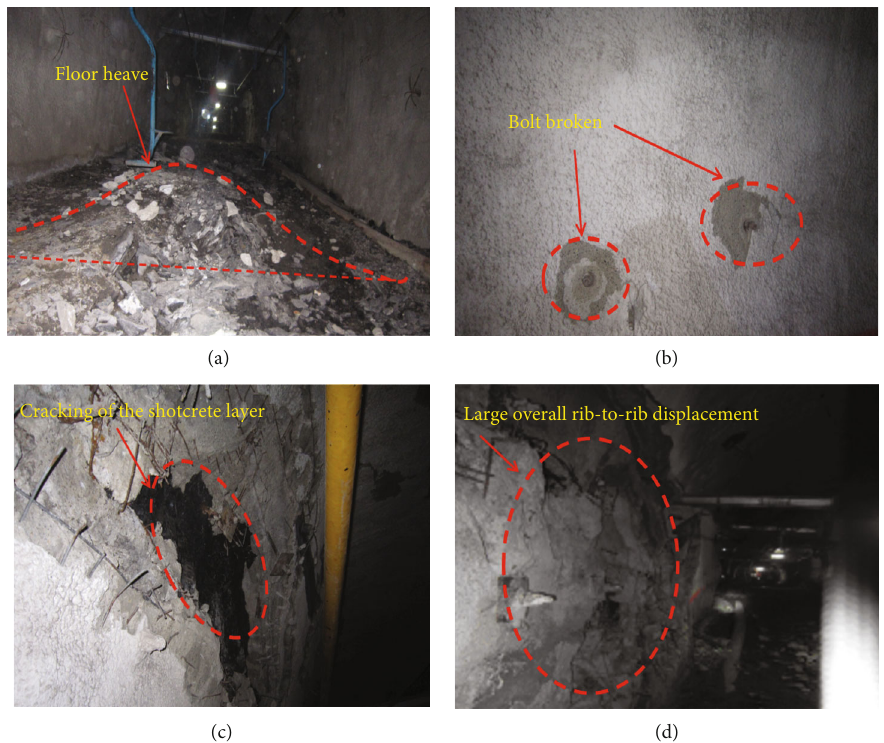
Figure 4: Deformation and failure of 1# main roadway. (a) Bolt broken. (b) Cracking of the shotcrete layer. (c) Large overall rib-to-rib displacement. (d) Floor heave.